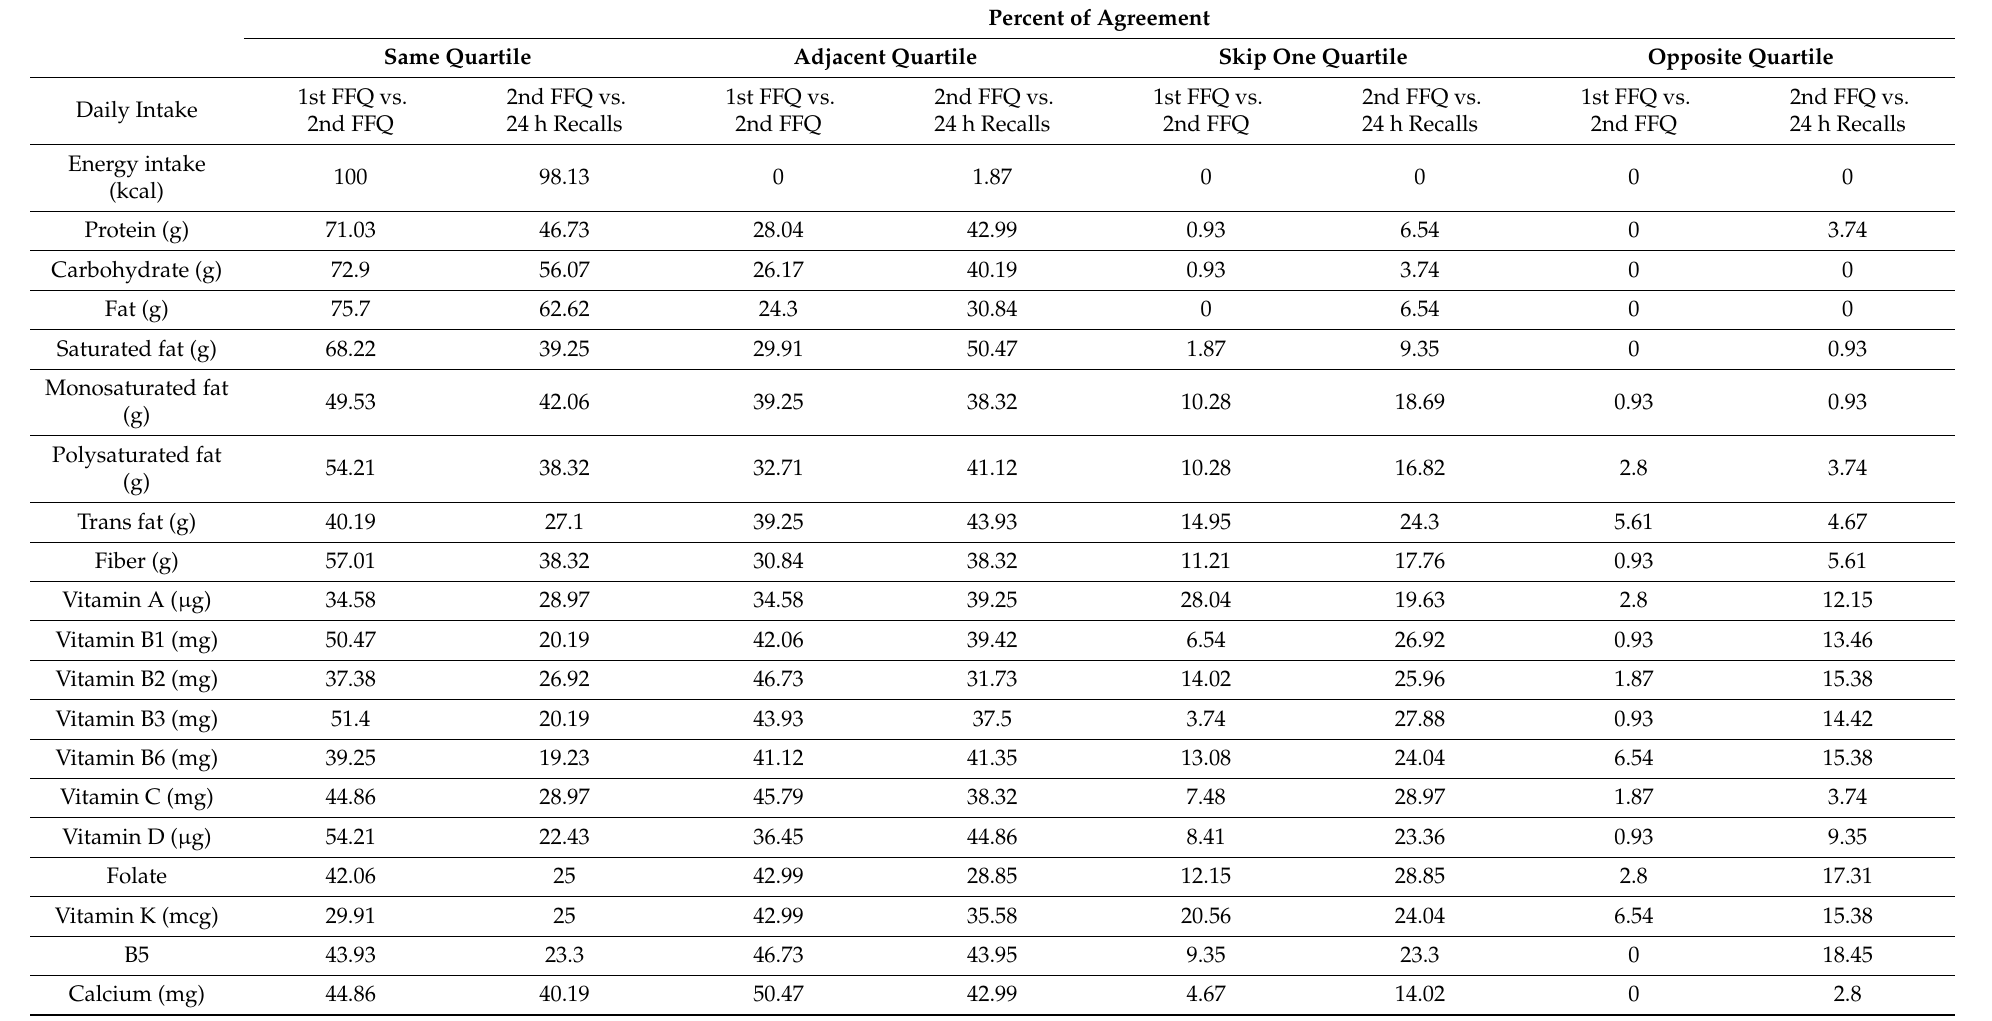
Table 3. Agreement in quartile distribution of nutrients intake between two FFQ surveys and 24 h